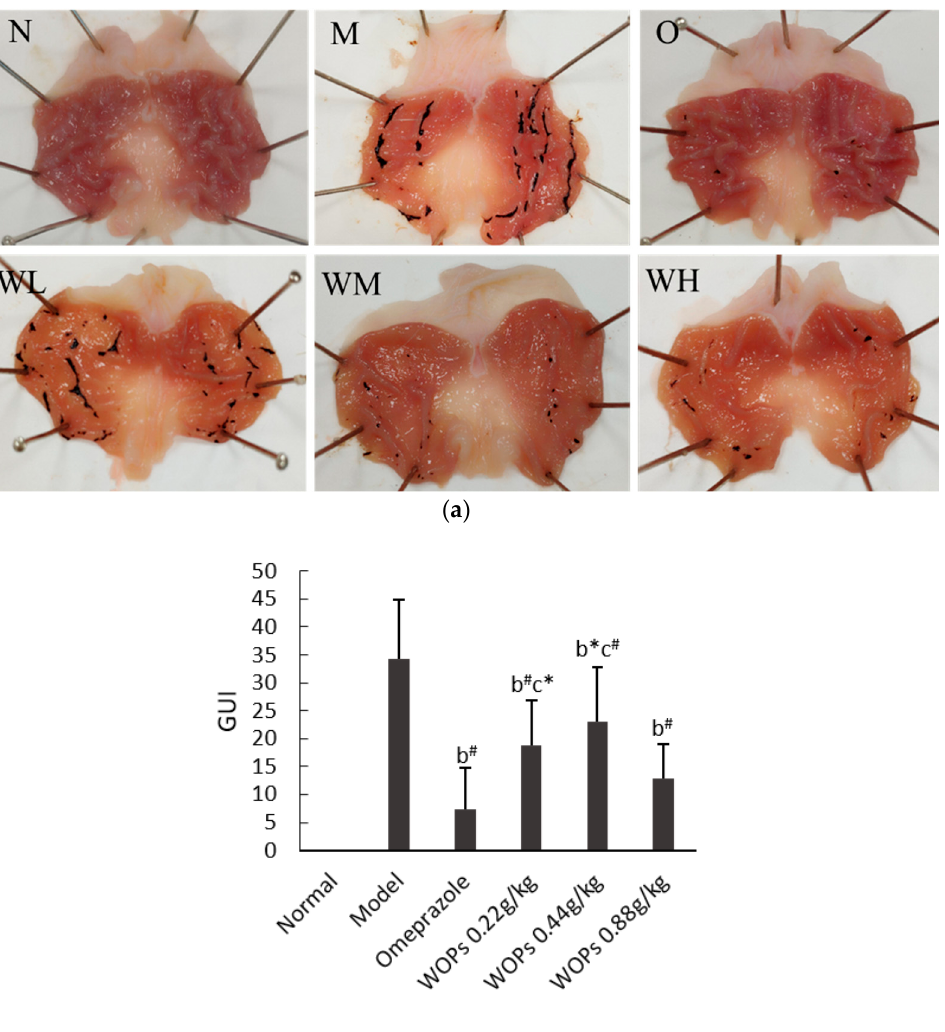
Figure 1. Effect of WOPs on gross appearances of gastric mucosal ( a ) and gastric ulcer index ( b ) in indomethacin-induced gastric ulcer in rats. N, normal group; M, model control group; O, omeprazole group (0.02 g/kg); WL, WOPs 0.22 g/kg; WM, WOPs 0.44 g/kg; WH, WOPs 0.88 g/kg. Significance was represented as * p < 0.05, # p < 0.01; b represents comparison with the model group and c refers to comparison with the omeprazole group; 10 per group. GUI, gastric ulcer index; WOPs, walnut oligopeptides.